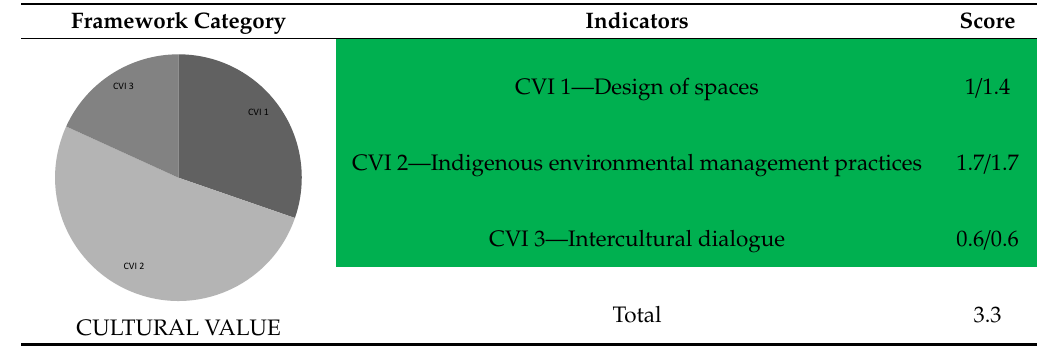
Table 14. RAG rating of Cultural Value Indicator in Louroujina.